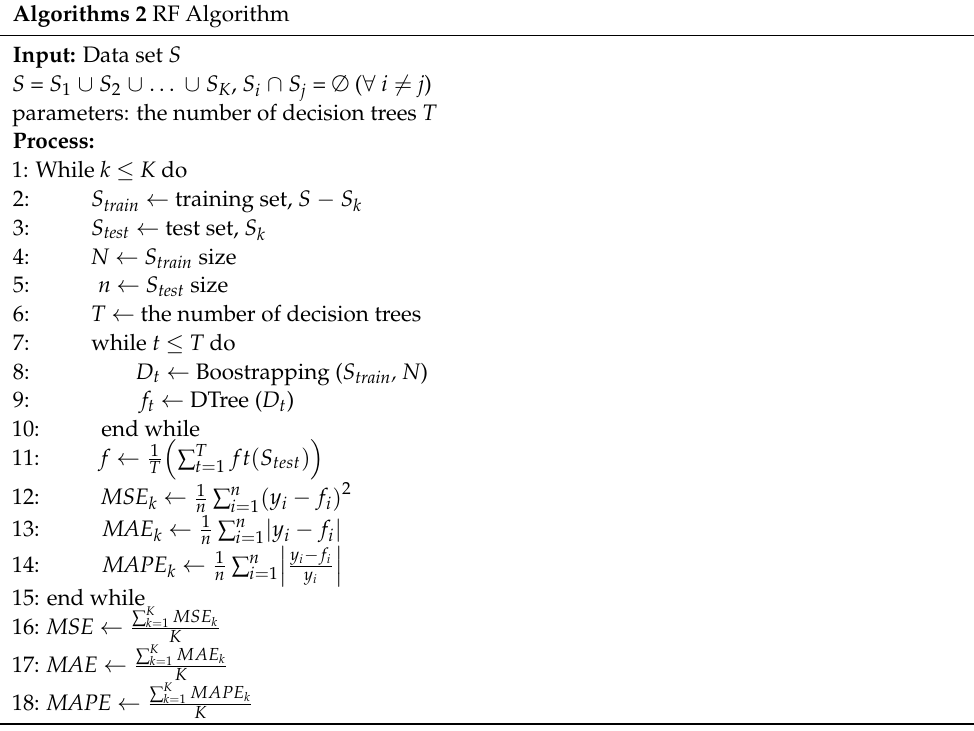
Algorithms 2 RF